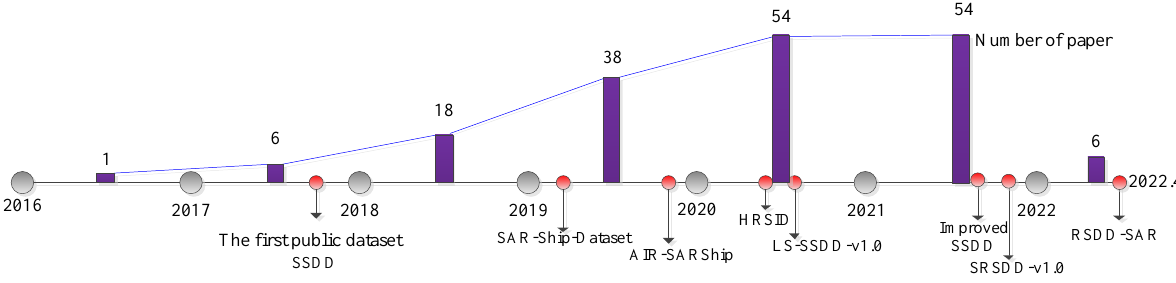
Figure 5. The timeline of the 177 papers. Gray lines and gray circles in the figure represent the time, the purple bar represents the number of papers in the current year, and the red circles represent the public time of the dataset. From the timeline, we can find that in the passing five years, the number of papers about deep learning-based SAR ship detectors becoming more and more. The period 2016–2017 is in the transitional period between traditional and deep learning methods, and there are sporadic papers. Additionally, due to the lack of a unified dataset and the lack of in-depth understanding of deep learning and computer vision algorithms, the application of deep learning algorithms is not thorough. This situation did not change until the emergence of the first dataset (SSDD) paper at the end of 2017. SSDD discloses the data and evaluation criteria it used, which lays the foundation for the rapid devel- opment of this field. Since then, the fast lane of research was opened, and a large number of papers were published. The milestones of this field are the several open-access da- tasets, which are shown in the red circle above. With the increase in available datasets, more and more researchers are paying attention to this field.